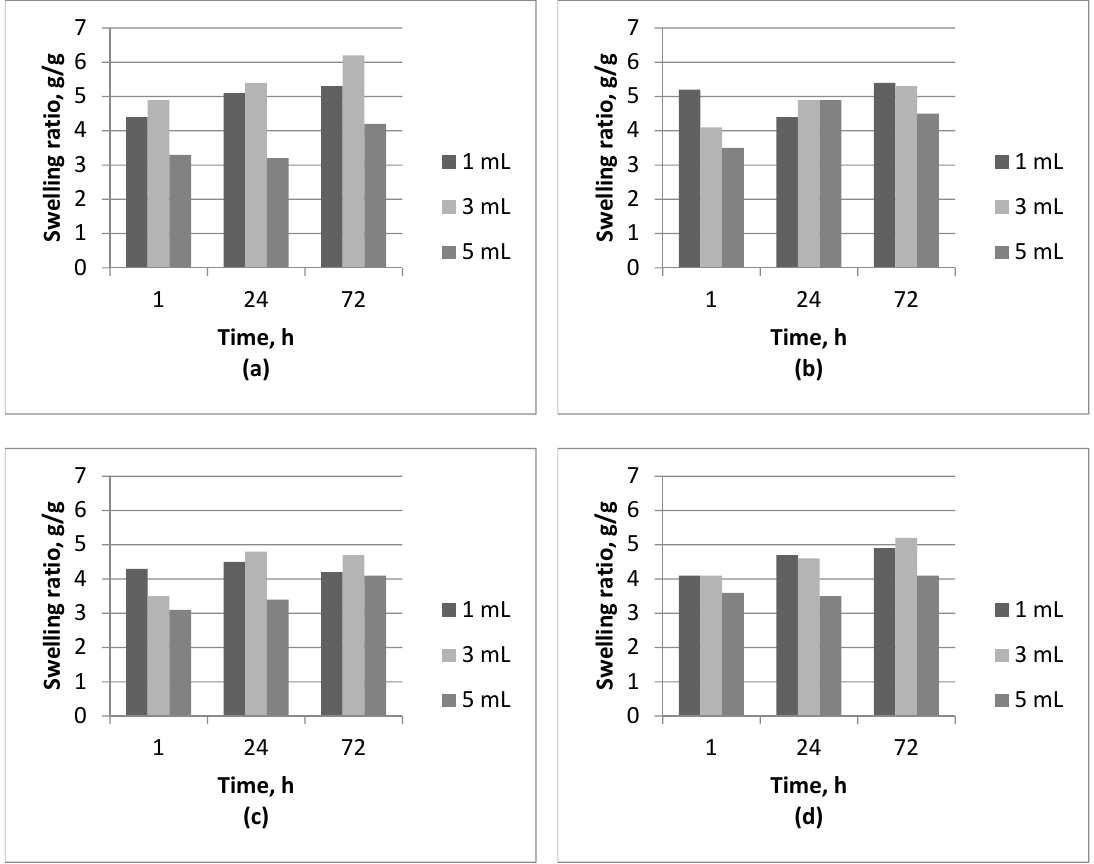
Figure 1. Comparison of swelling ability of Beetosan ® hydrogels in: ( a ) SBF; ( b ) artificial saliva; ( c ) Ringer’s liquid; and ( d ) distilled water.